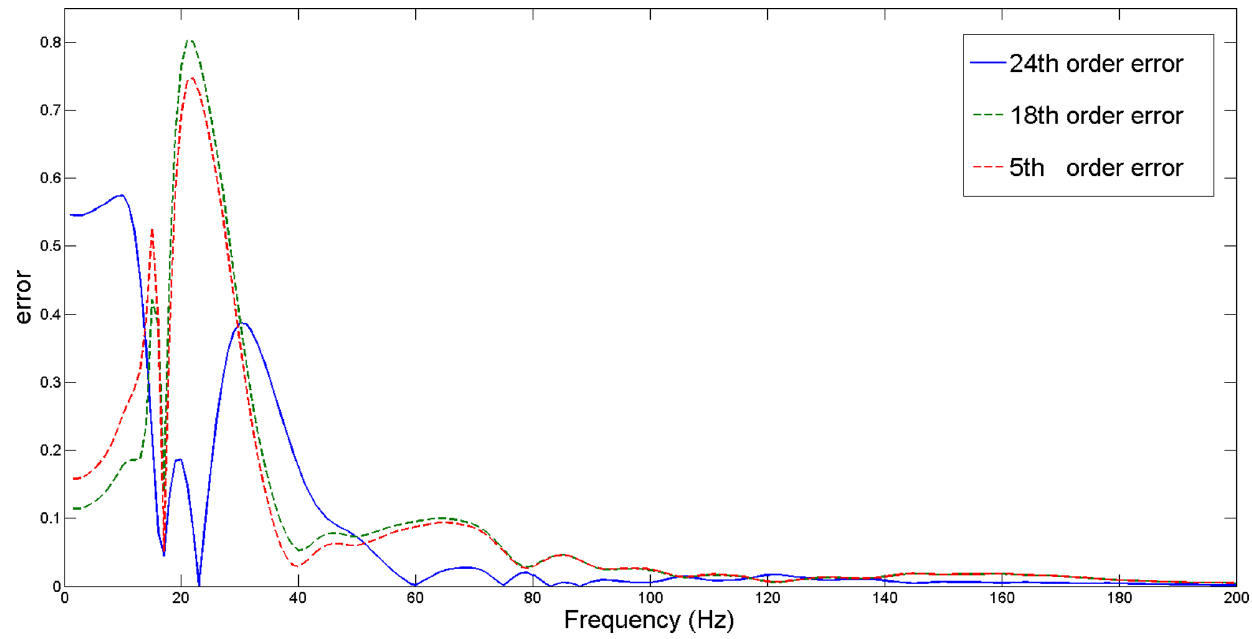
Figure 4. Spectrum matching error for different filter orders. A comparison of matching errors in replicating a S3 heart tone spectrum. The presented curves indicate errors for three filters estimated by a Linear Predictive Coding algorithm with a transfer function of the 5th (red dotted line), 18th (green dotted line) and 24th (blue line) order. The 24th order filter obtained significantly lower error.